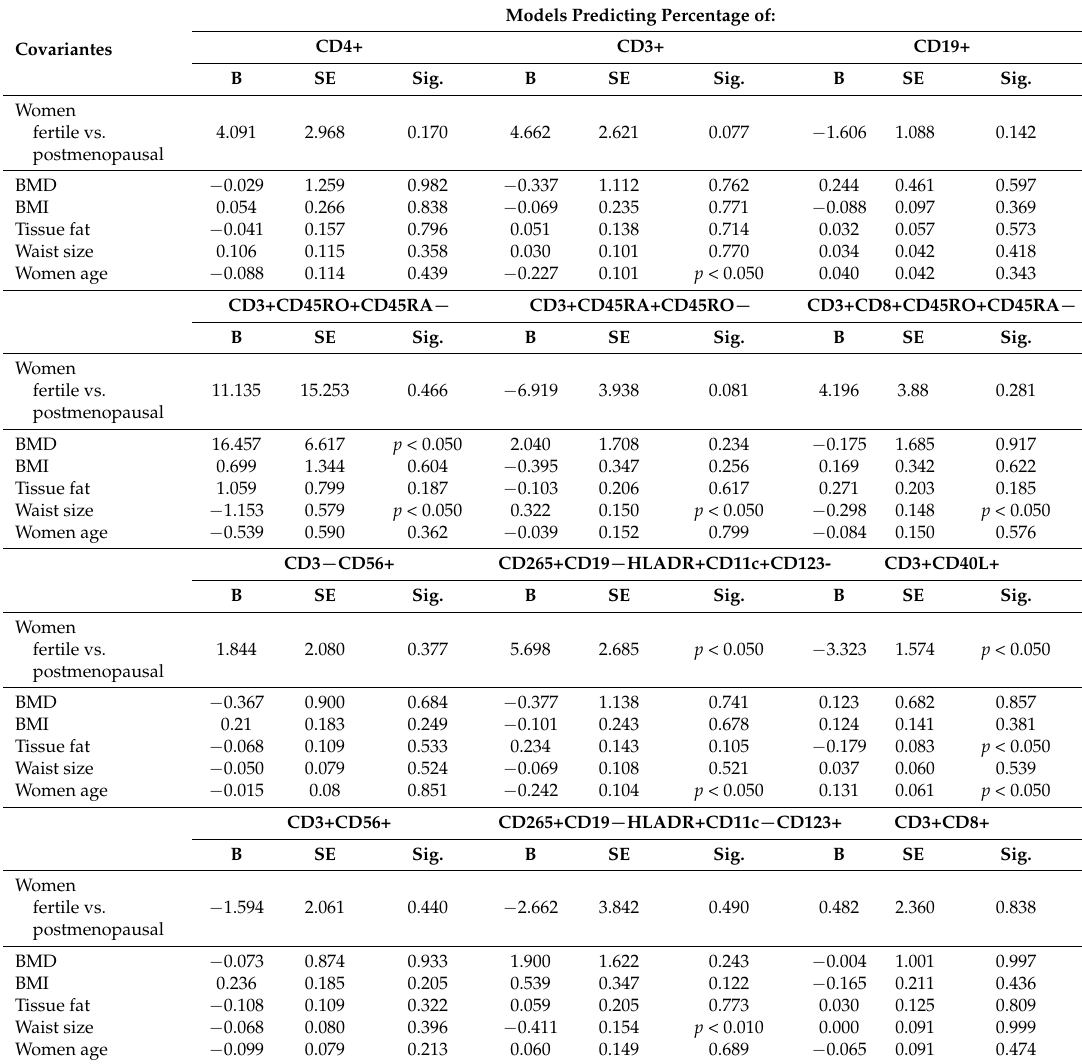
Models Predicting Percentage